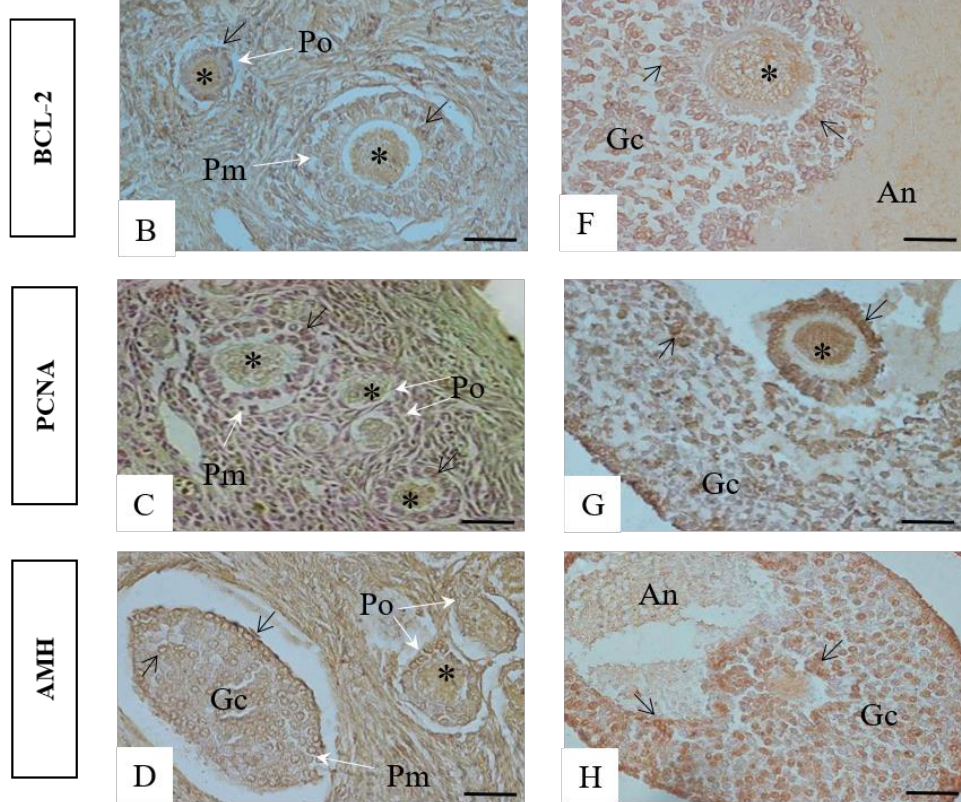
Figure 1. Photomicrographs of ovarian immunostaining for cleaved Caspase-3, BCL-2, PCNA, and AMH in granulosa cells and oocytes of the primordial and primary follicles ( A – D ) and small and large antral follicles ( E – H ) of Ma’s night monkeys ( Aotus nancymae ) and large-head capuchins ( Sapajus macrocephalus ). A: Negative control; Abbreviations: Po: Primordial follicle; Pm: Primary follicle; T: Theca layers; Gc: Granulosa cells; An: Antrum; *: oocytes. Arrow: immunostained granulosa cells. Hematoxylin – Eosin. Bar Scale: 25 µm.